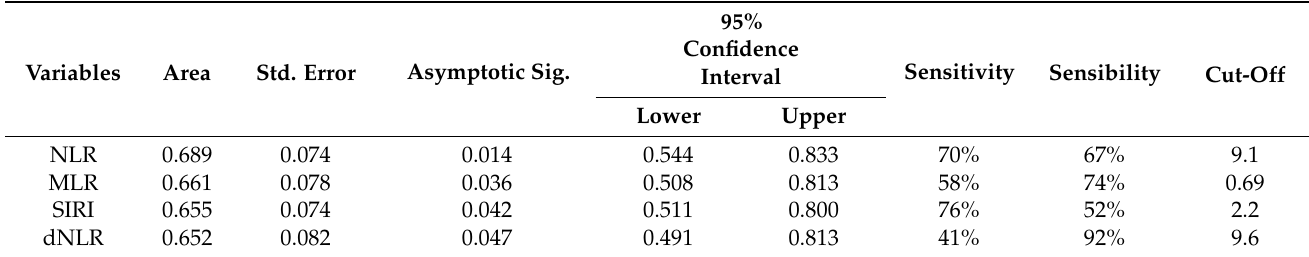
Table 2. Receiver operating characteristics (ROC) curves, prognostic accuracy of inflammatory markers, and optimal cutoff.